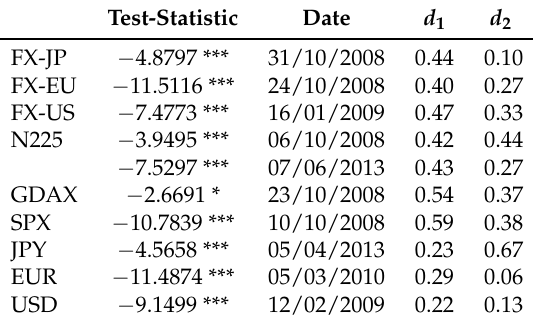
Table 9. Persistence change test.